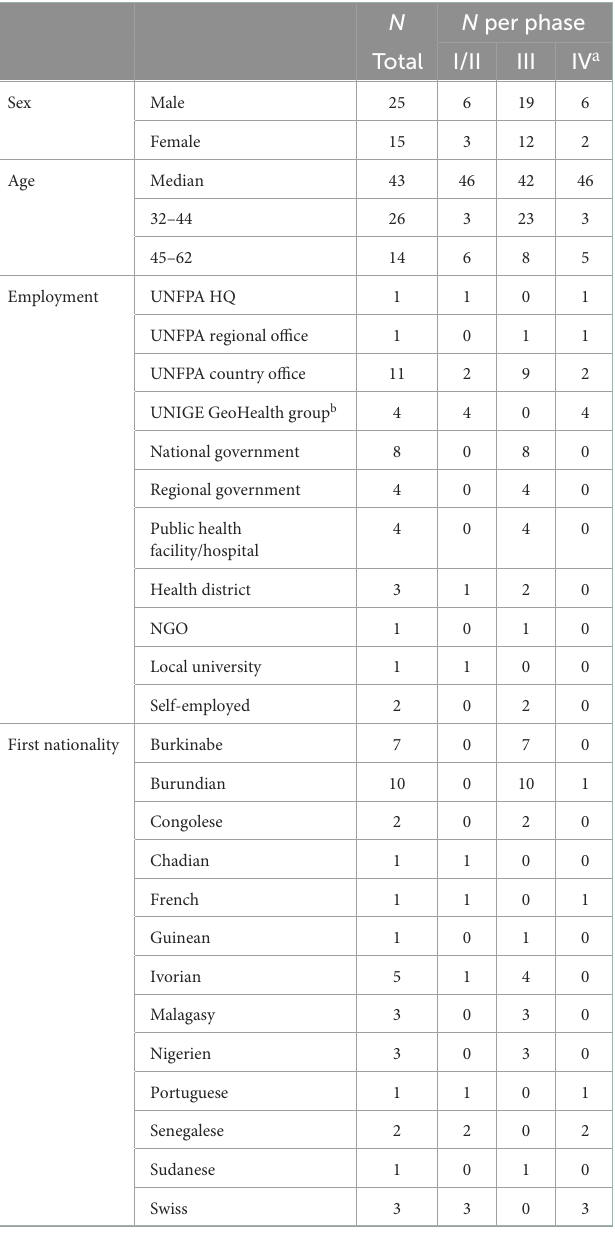
TABLE 1 Characteristics of the study participants ( N = 40).